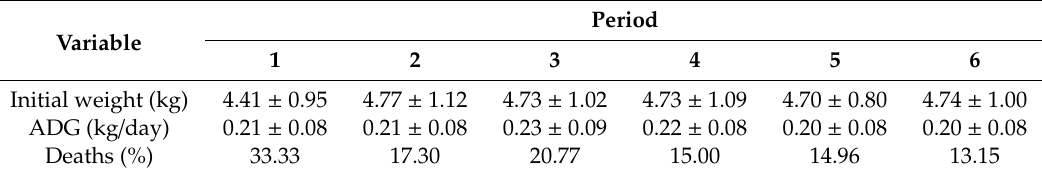
Table 5. Tests of between-subjects effects table, in which the period of study was the independent variable, the initial weight was the covariate, and the ADG was the dependent variable.